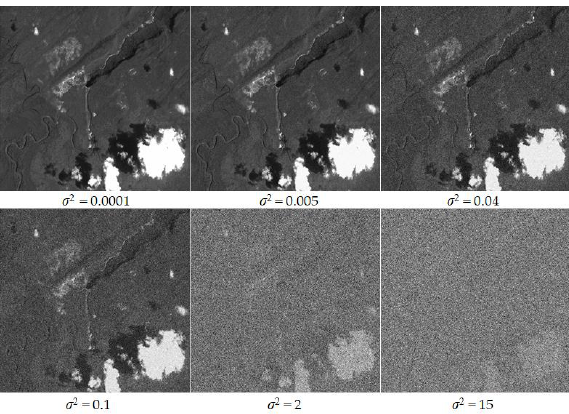
Figure 5. Visualization of Figure 1e under different noise levels. Table 4. The noise estimation results of the references and the proposed